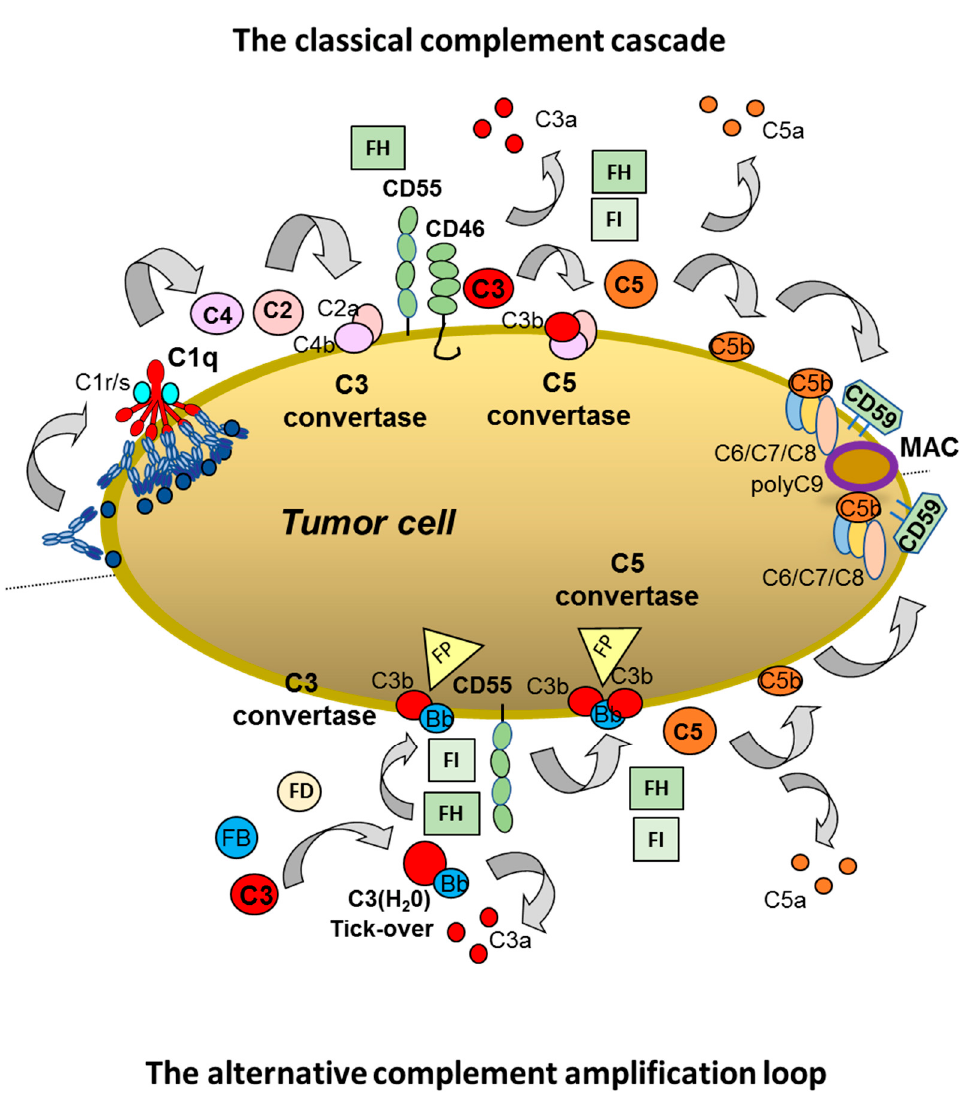
Figure 1. The classical and alternative complement pathways. The classical pathway ( top ): Human IgG1 antibodies bind antigen, form hexamers that allow C1q binding and the activation of the classical complement cascade. This is followed by C2 and C4 cleavage to produce the membrane bound C3 convertase (C4bC2a complex). Further cleavage of C3 to C3a and C3b forms the C5 convertase (C4bC2aC3b). C5 is cleaved to C5a and C5b allows further recruitment and activation of the C6, C7 and C8 components which catalyze C9 polymerization forming the membrane attack complex (MAC). The alternative pathway ( bottom ): it is initiated by tick-over activation of C3 in the fluid phase (C3(H 2 O)). It is further activated by Factors B and D to form the alternative C3 convertase (C3bBb) which is stabilized by Properdin (FP, yellow triangle). Further C3 cleavage forms the C5 convertase (C3bBbC3b) (also stabilized by Properdin). The alternative pathway amplifies the classical pathway. Both pathways are inhibited by the soluble inhibitors Factor H (FH) and Factor I (FI) and by membrane bound inhibitors: CD46 and CD55 at the level of the C3 convertase and CD59, which inhibits C9 polymerization. Complement pathway inhibitors are shown in green.